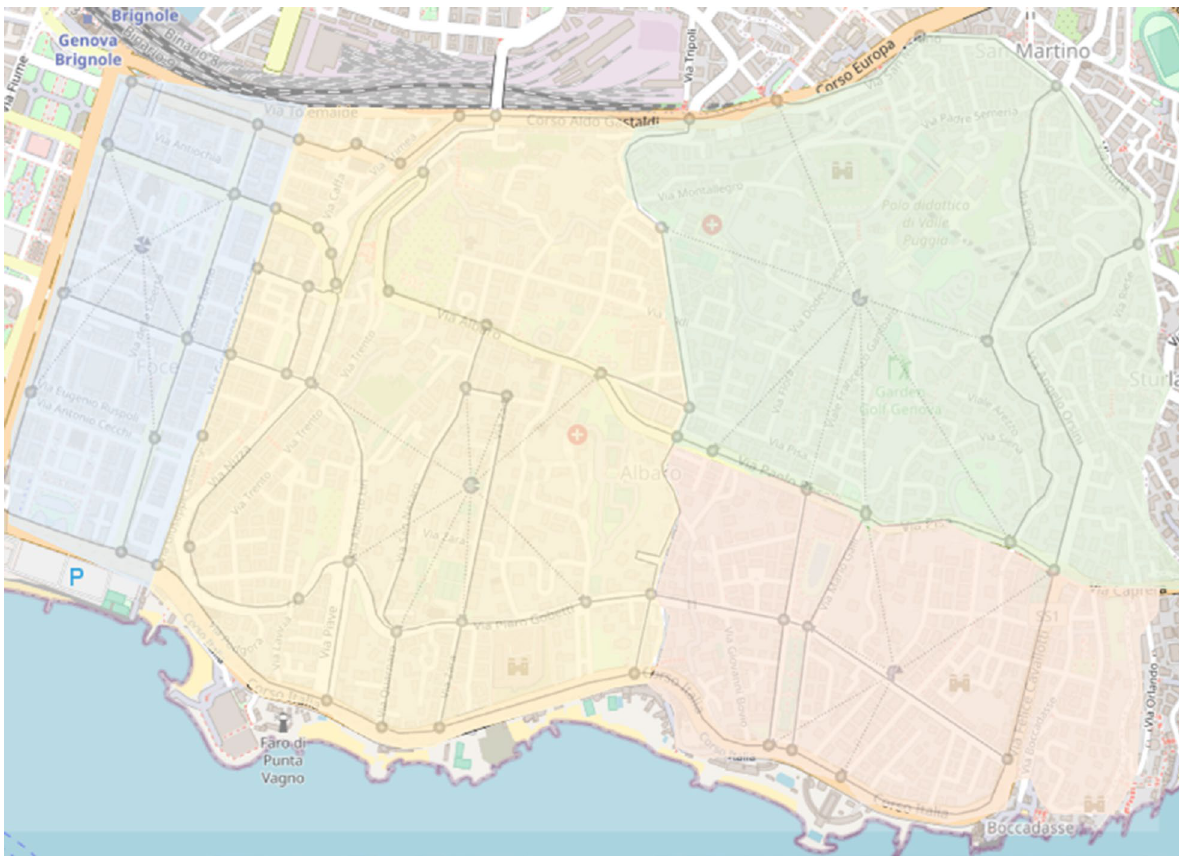
Fig. 3 Real Network for application of formulated model